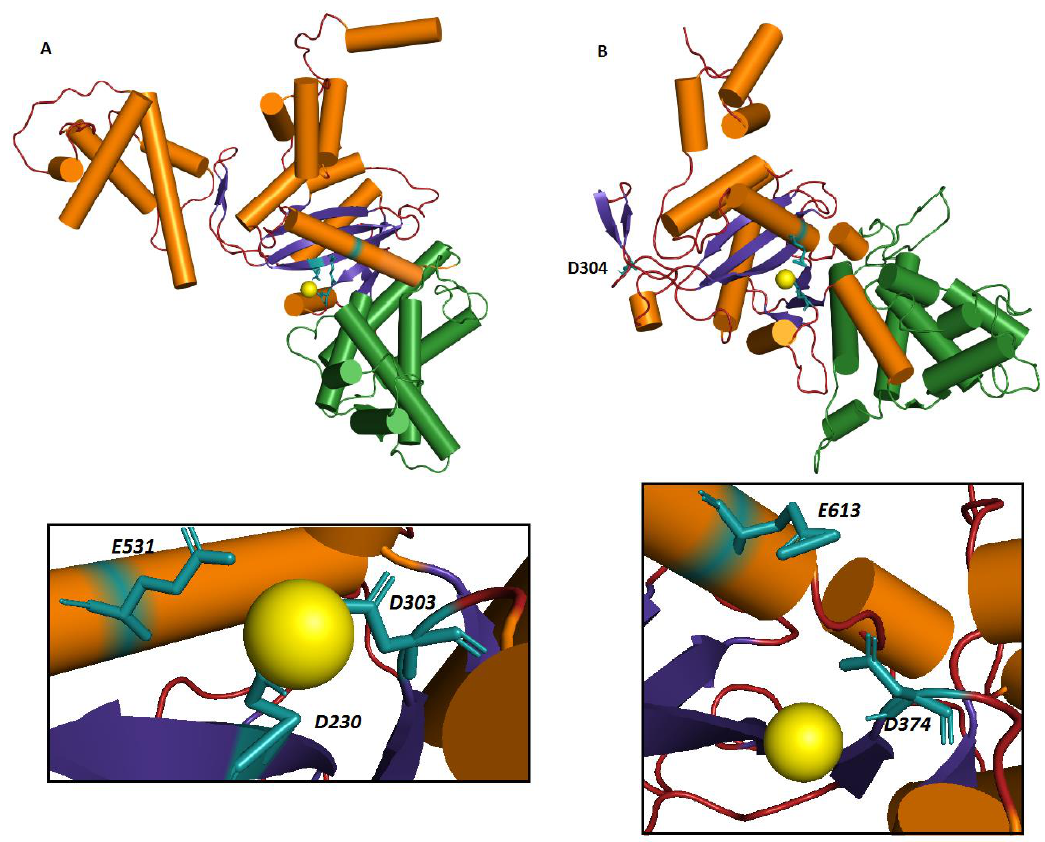
Figure 2. Predicted catalytic triad shown in the 3D structure of hTHAP9, built using homology modeling. ( A ) DmTNP structure with beta sheets (blue arrows), helices (orange rods) and insertion domain (green) (PDB ID-6P5A(12)). The active site is shown in the inset with DDE motif (D230, D303, E531) in close proximity to the magnesium ion (light yellow). ( B ) Homology model of hTHAP9 with the magnesium ion. Active site shown in the inset has D374 and E613 close to the magnesium ion (yellow). D304 does not adopt any secondary structure but follows immediately after a beta sheet.